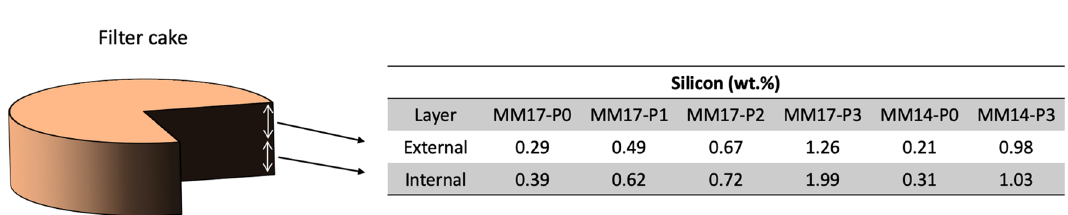
Figure 11. Filter cake diagrams for the low-density and high-density samples to show the perlite distribution among the filter cake.